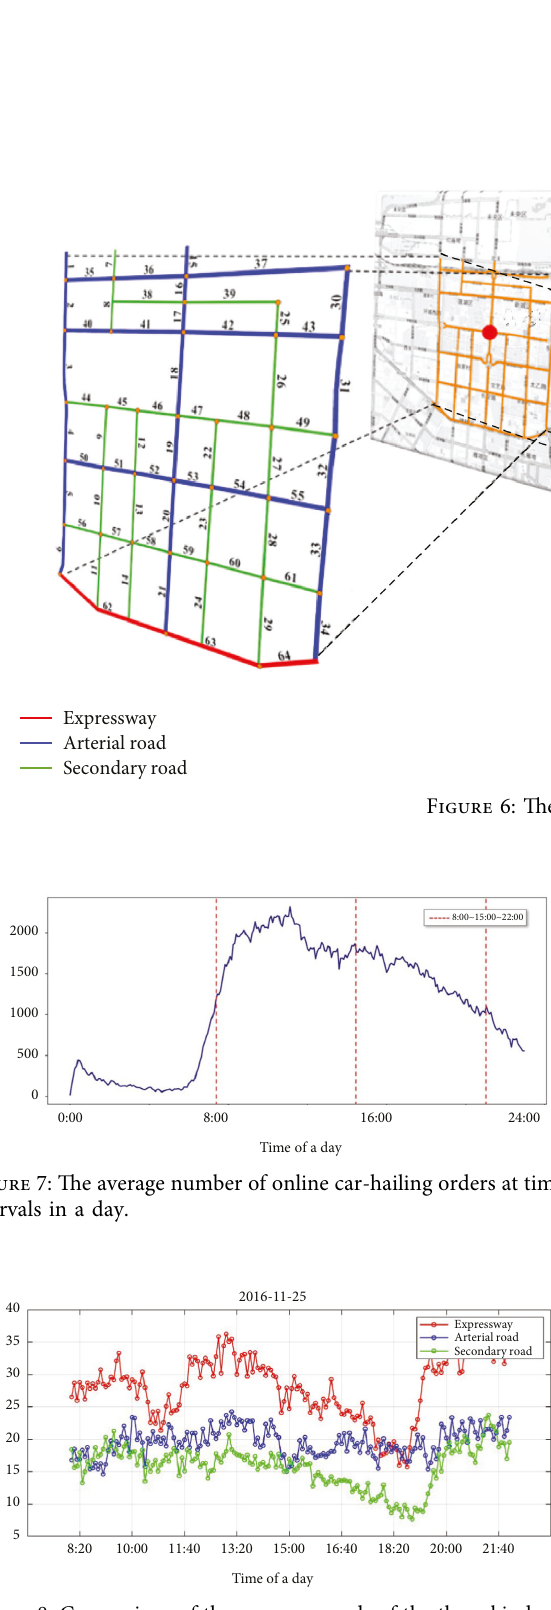
Figure 8: Comparison of the average speeds of the three kinds of roads in a day.